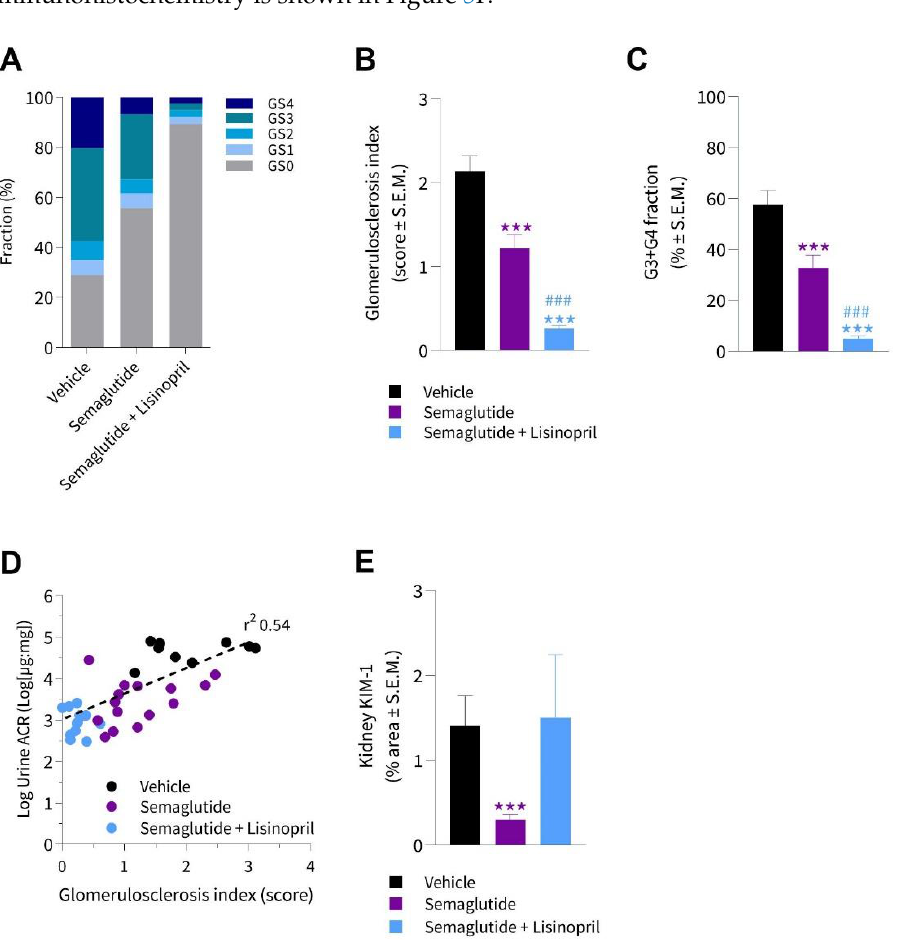
Figure 5. Semaglutide improves glomerulosclerosis in db / db UNx-ReninAAV mice. Automated AI- based detection of glomerulosclerosis in PAS-positive glomeruli in db / db UNx-ReninAAV mice re- ceiving (q.d.) vehicle, semaglutide (30 nmol/kg, s.c., n = 15) or semaglutide (30 nmol/kg, s.c., n = 15) + lisinopril (30 mg/kg, p.o., n = 14). ( A ) Group-wise distribution (fraction %) of glomerulosclerosis scores. ( B ) Glomerulosclerosis index. ( C ) Fraction of glomeruli with severe or global glomeruloscle- rosis (GS3 + GS4). ( D ) Correlation of glomerulosclerosis index and albuminuria. ( E ) Fractional (%) area of whole-section kidney molecule-1 (KIM-1). ( F ) Representative photomicrographs from db / db UNx-ReninAAV mice receiving vehicle, semaglutide or combined semaglutide + lisinopril admin- istration. *** p < 0.001 vs. vehicle-dosed db / db UNx-ReninAAV mice; ### p < 0.001 vs. semaglutide (Dunnett’s test one -factor linear model with interaction). Scale bar, 100 µm.